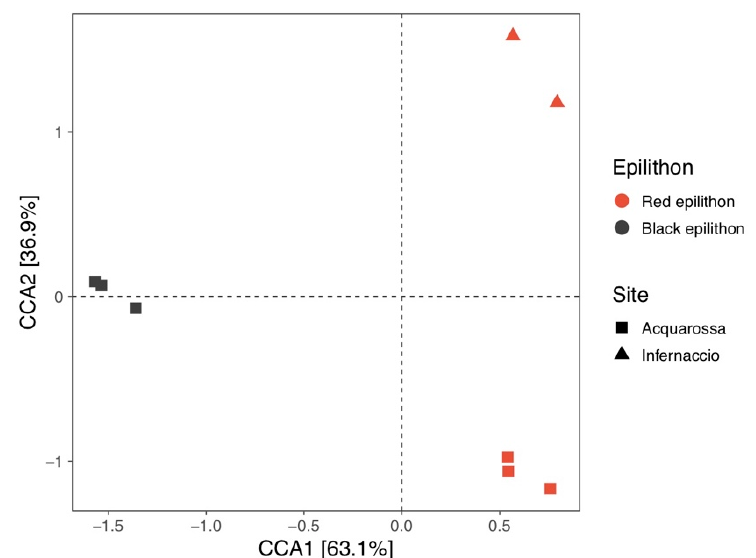
Figure 3. Canonical correspondence analysis of bacterial communities from different epilithon types and different sampling sites. Epilithon types were reported using different colors whereas sampling sites were reported using different point shapes. Values between squared brackets represent the value of inertia explained by the given axis.